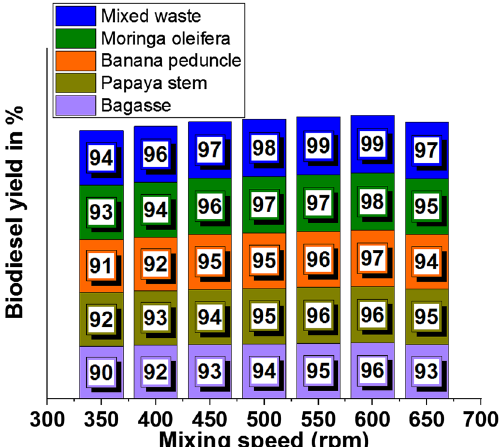
Figure 11. Comparison of biodiesel yield with different plant waste (mixing